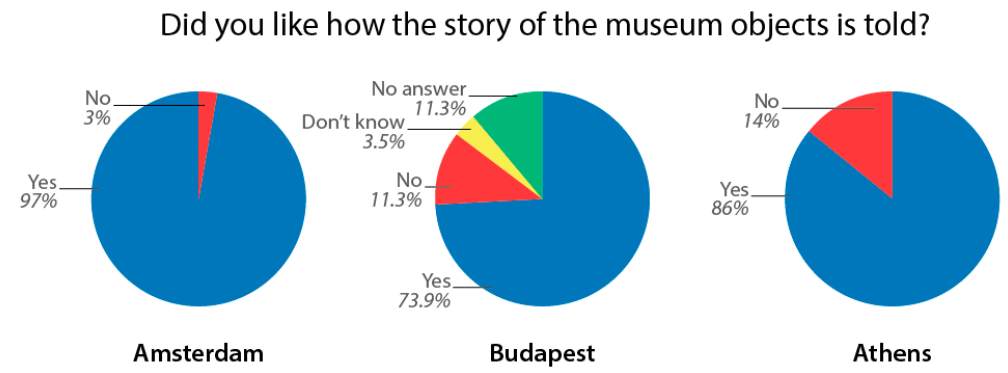
Figure 19. Image representing the results of one of the questions done to museum visitors about storytelling, at APM, NHM, and BCM.